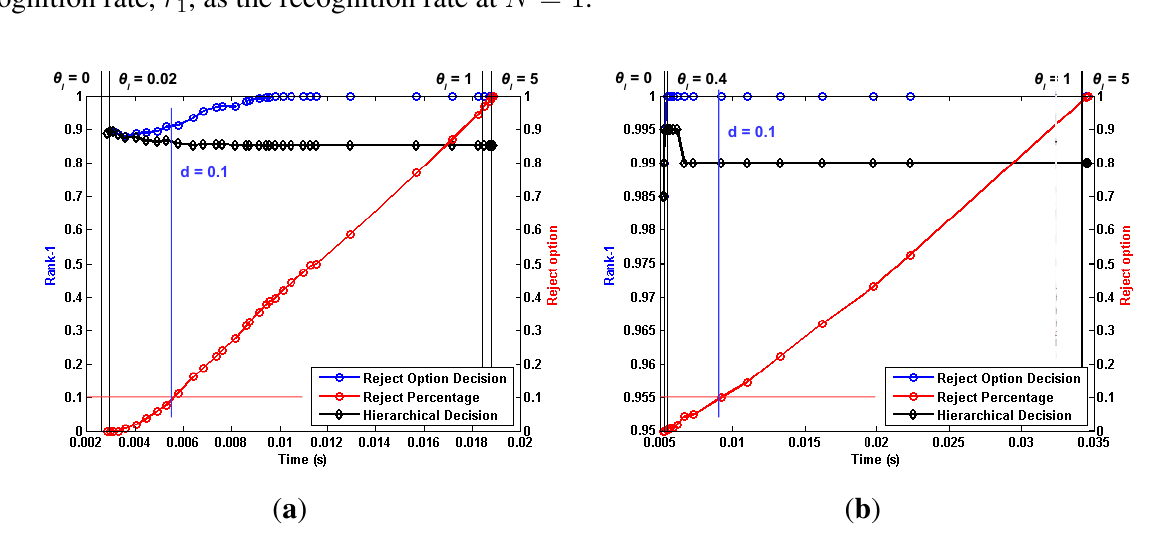
Figure 5. Main results obtained with the proposed methodology for the sunglasses and scarf images of the ORL face database. Each plotted point represent a specific value of parameter θ , ranging from [0 , ∞ ] l